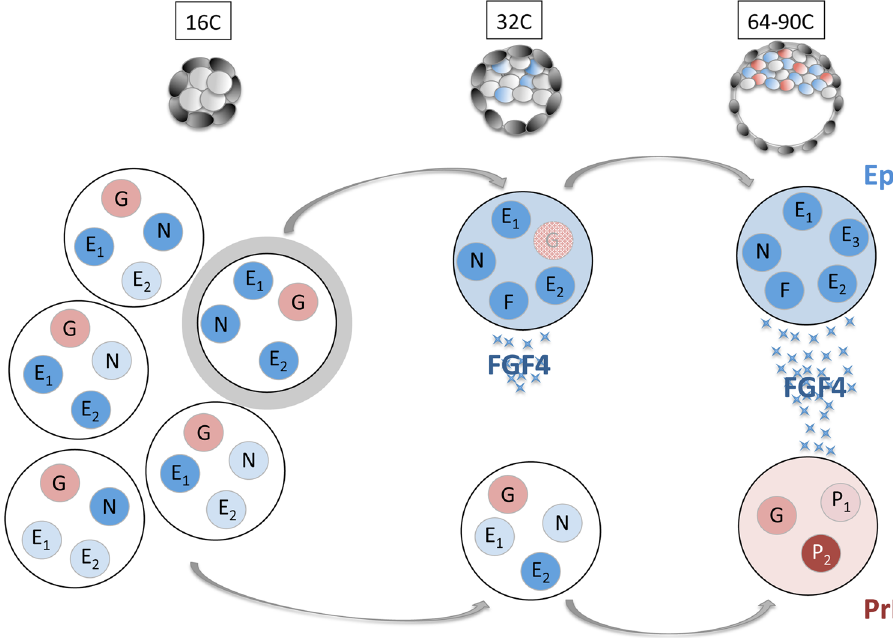
Fig. 5 Schematic model of Epi differentiation. At the 16C stage, all ICM progenitor cells express various Epi genes (blue, E1, E2 … ) including NANOG (N), at different levels (colour intensity) without correlation. GATA6 (G) is expressed at similar levels in all cells. Some cells (highlighted in grey) randomly co- express NANOG with other Epi factor(s). Only in these cell(s), the co-expression promotes the coordinated expression of Epi factors that induces the Epi state at the 32C state and boosts Fgf4 expression (F). After the 32C stage, FGF4 is strongly secreted by Epi cells, enabling the differentiation of their undifferentiated neighbours into PrE cells that express speci fi c PrE markers (red, P1,